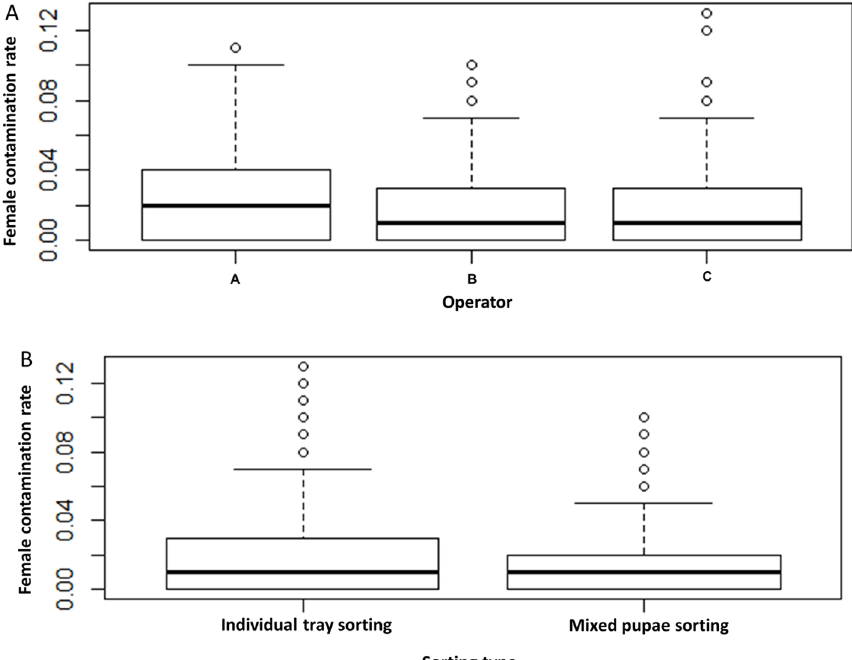
Figure 6. Female contamination rate as (A) a function of the operator and (B) sorting type in Aedes aegypti. Signi fi cant variation in female contamination rate between operators. Data presented in the fi gure are expressed as mean ±